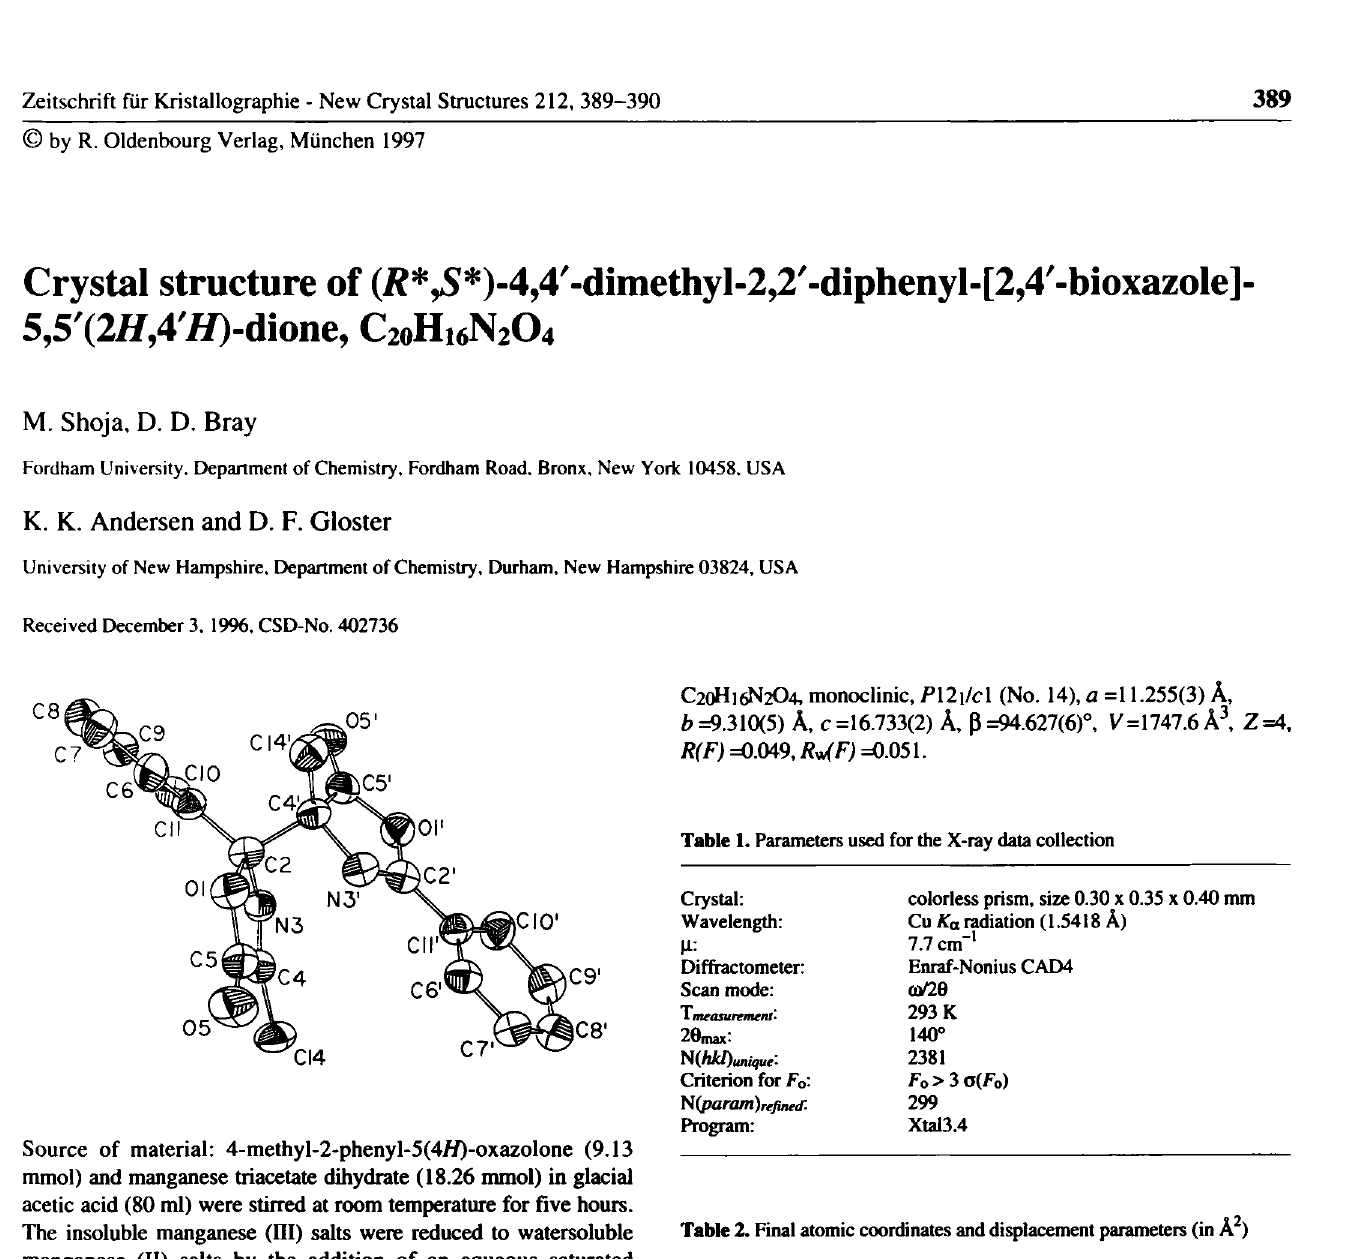
Table 2. Final atomic coordinates and displacement parameters (in Â 2